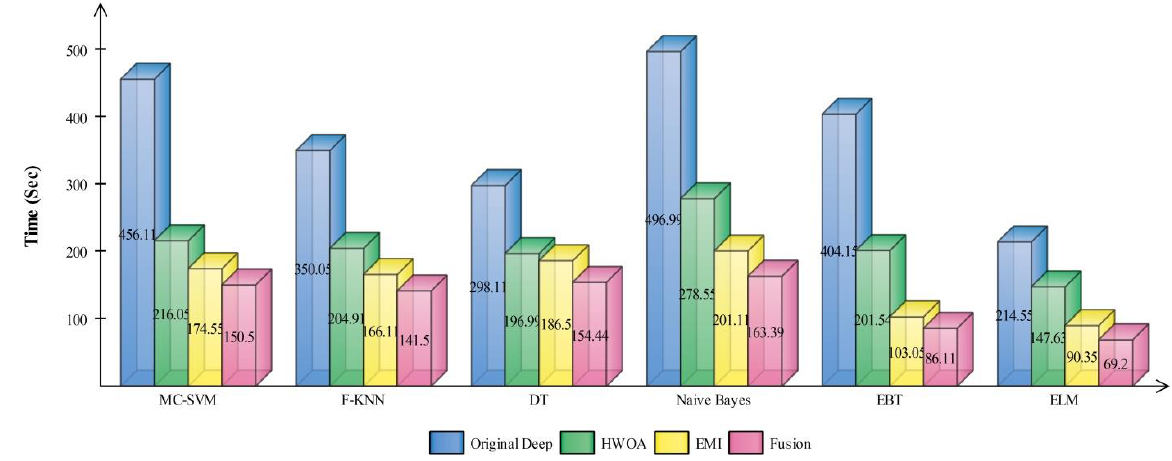
Figure 10. Computational time based comparison among middle steps for HAM10000.